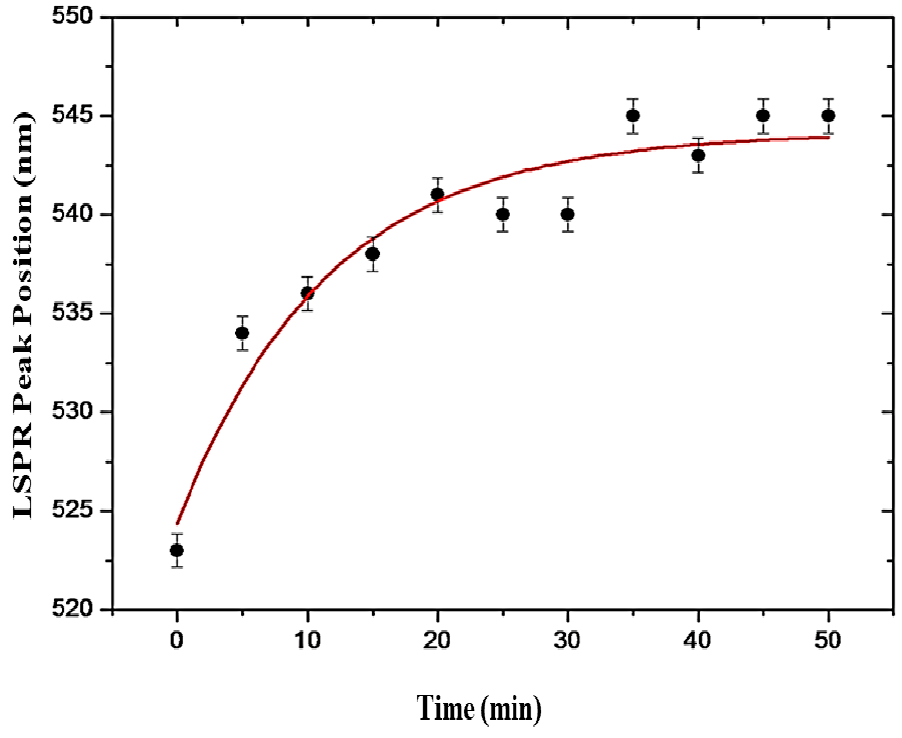
Figure 7. The LSPR spectral shift of AuNPs for 25 nm on the adsorption of cysteamine with increasing time.